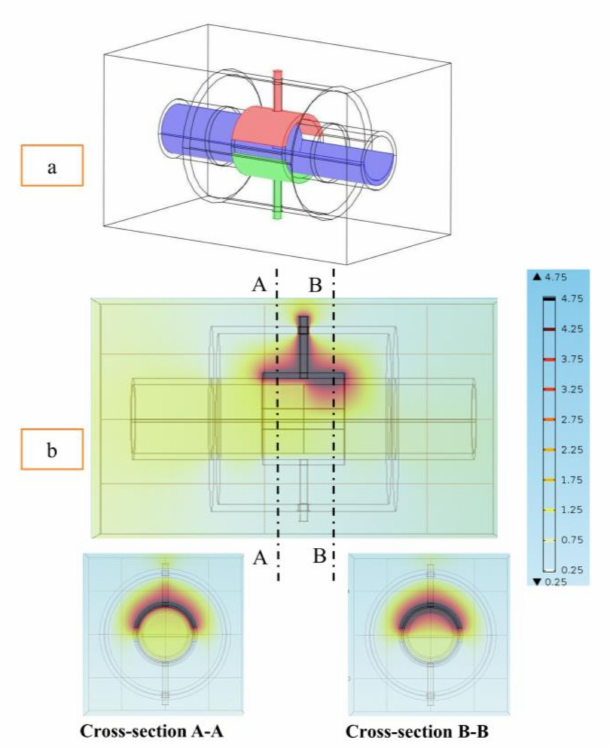
Figure 7. ( a ) Simulated slug flow patterns were investigated numerically using the COMSOL program, and ( b ) the slug flow pattern’s electrical potential distribution in the simulated capacitance sensor (the unit of the contour line is V /